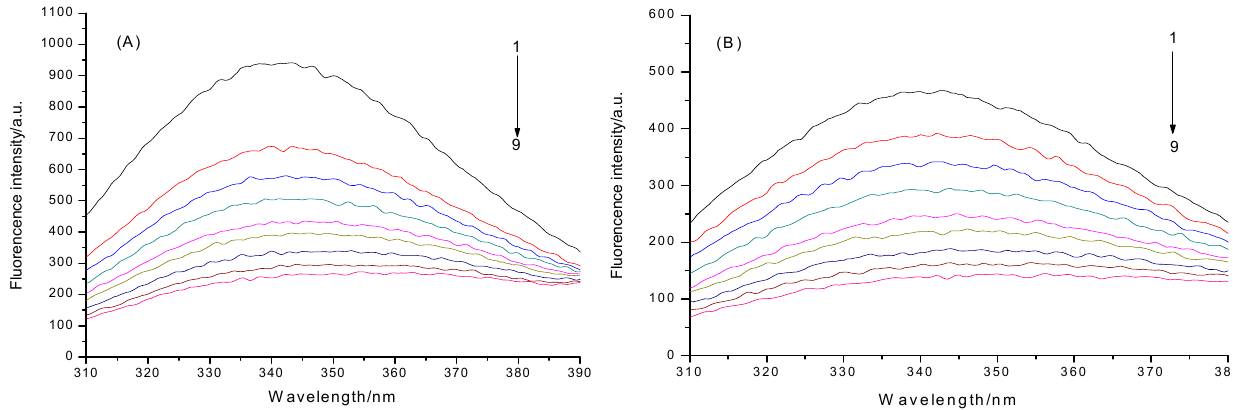
Figure 1. Fluorescence spectra of CYPs in the presence of various concentrations of puerarin (T = 303 K, concentrations of puerarin (1 → 9): 0, 0.5, 1, 1.5, 2, 2.5, 3, 3.5 and 4 × 10 − 5 mol L − 1 ). ( A ) puerarin-CYP1A2; ( B )